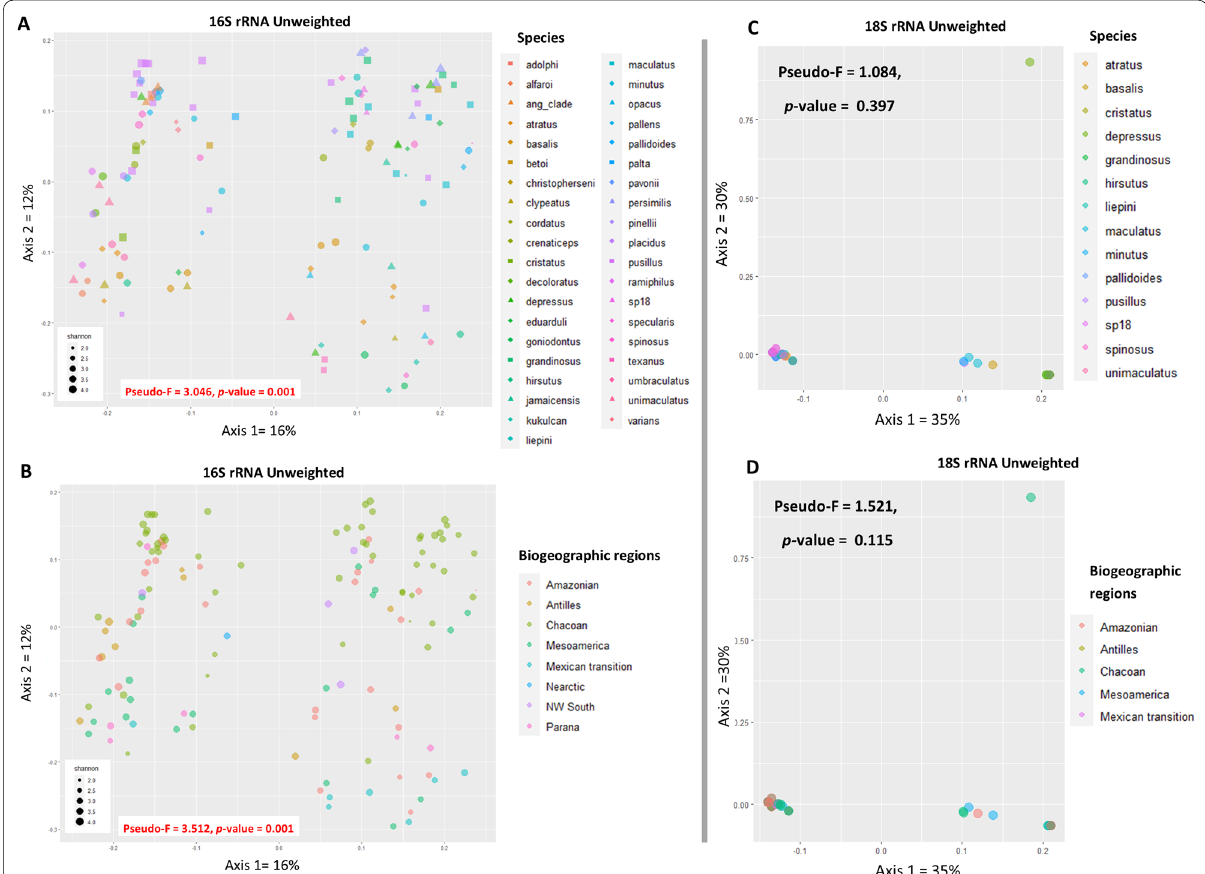
Fig. 3 Impact of composition and abundance of the bacterial community (16S rRNA) and of microbial eukaryotes (18S rRNA) associated with Cephalotes (beta diversity) belonging to different host species and biogeographic regions. A PCoA of bacterial community (unweighted unifrac distance matrix) of different Cephalotes species. B PCoA of bacterial community (unweighted unifrac distance matrix) of different biogeographic regions. C PCoA of microbial eukaryotic communities (unweighted unifrac distance matrix) of different Cephalotes species. D PCoA of microbial eukaryotic communities (unweighted unifrac distance matrix) of different biogeographic